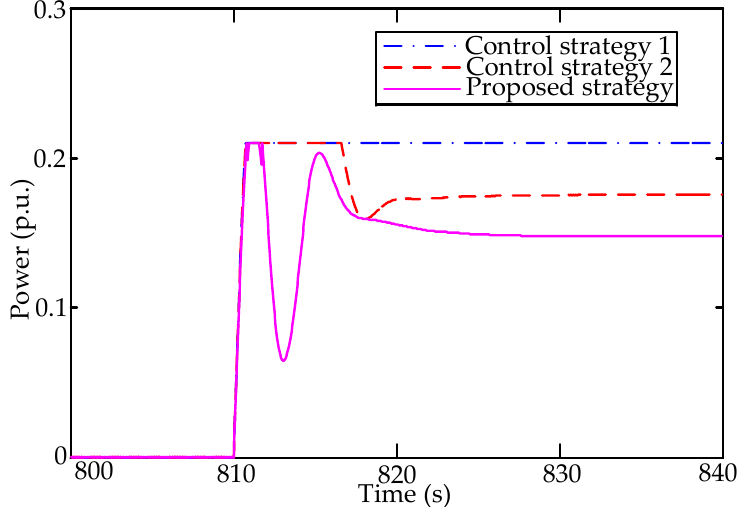
Figure 5. The power output of regulation generators under different control schemes.